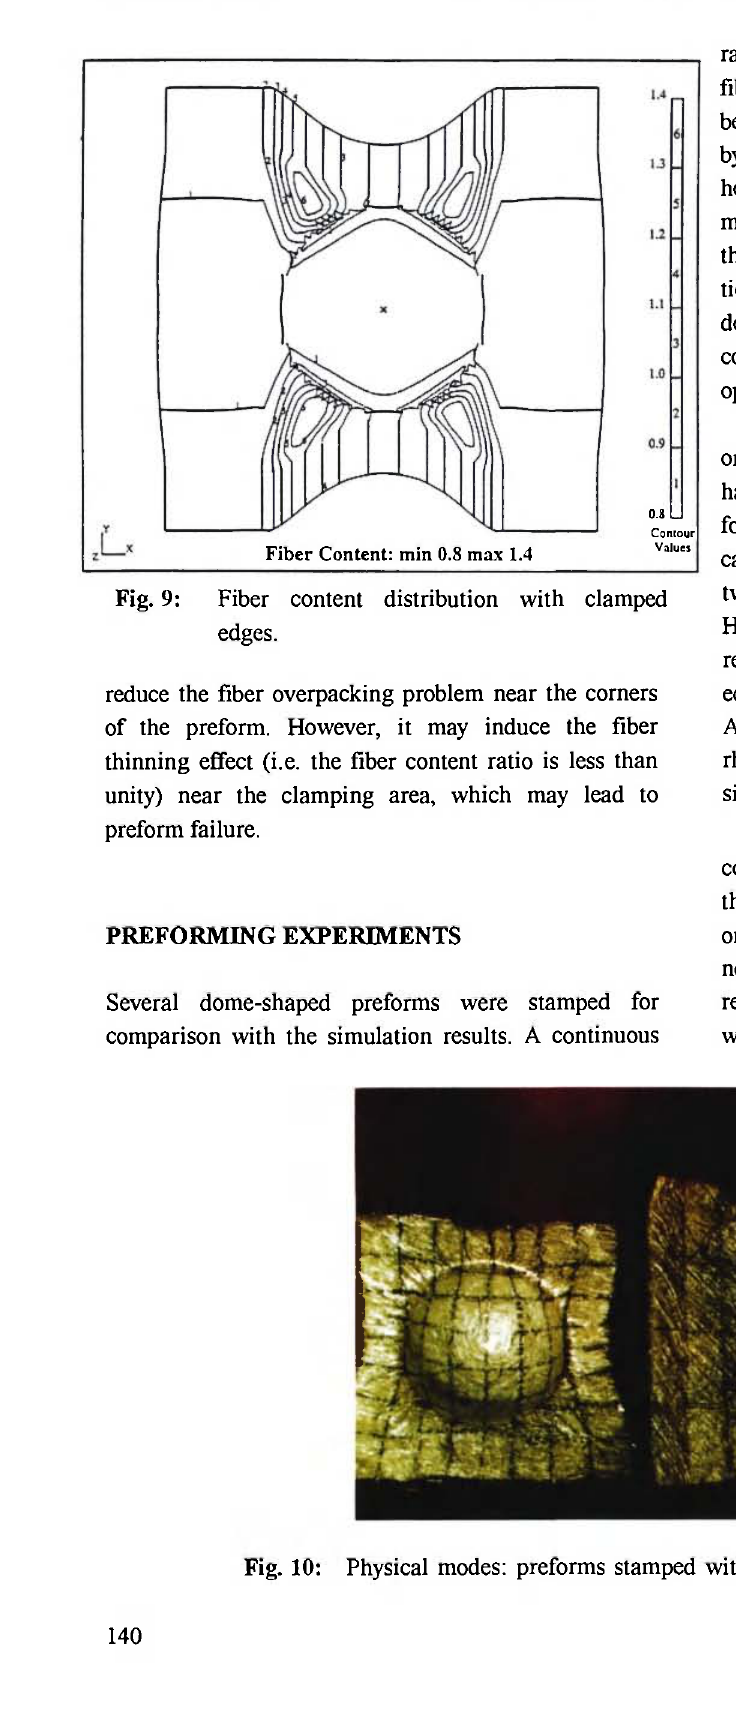
Fig. 10: Physical modes: preforms stamped with free draw-in and with two fixed